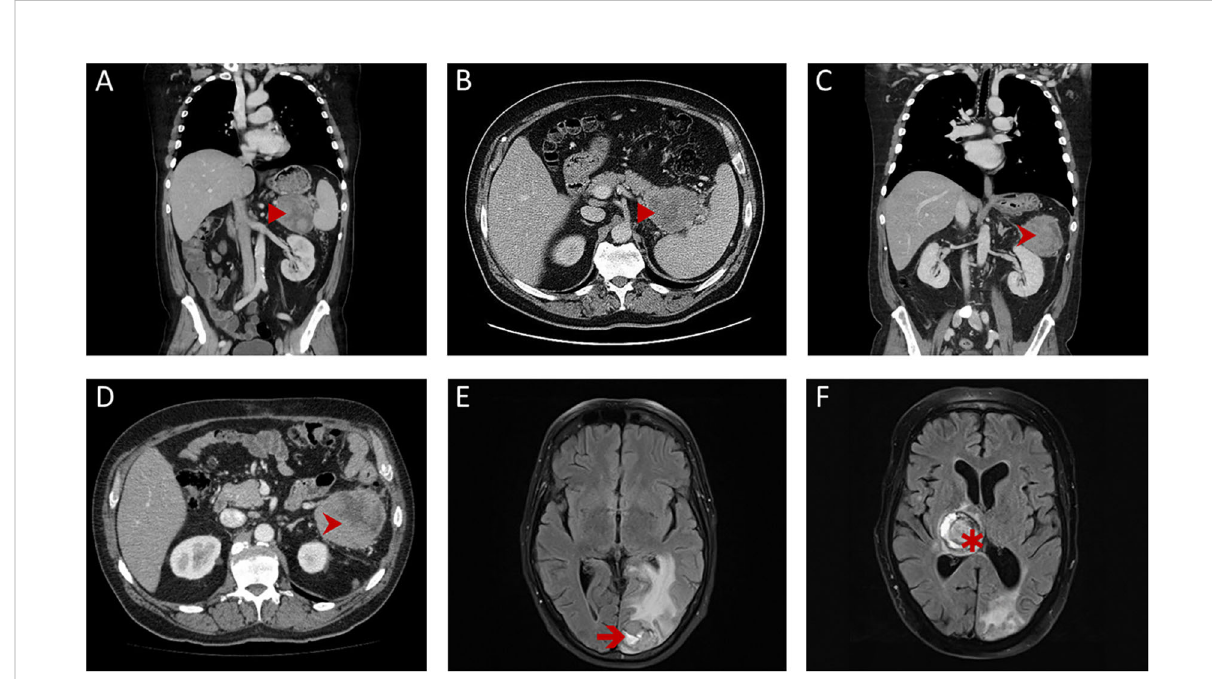
FIGURE 1 Radiological fi ndings. First contrast-enhanced computed tomography (CEPT; A , B ) of the thorax and abdomen revealed a large tumor ( ► ) of the pancreatic tail, close to the splenic hilum with a pseudo-encapsulated appearance. Follow-up CEPT (C, D) showed isolated local recurrence ( ➤ ) with similar features in the left-upper abdomen and the retroperitoneum. Repeated magnetic resonance imaging scans of the brain showed a left occipital metastasis ( ➔ ) shortly after resection for local recurrence (E) and a rapidly progressing metastasis of the thalamus region ( ✱ ) over the course of palliative systemic treatment (F)